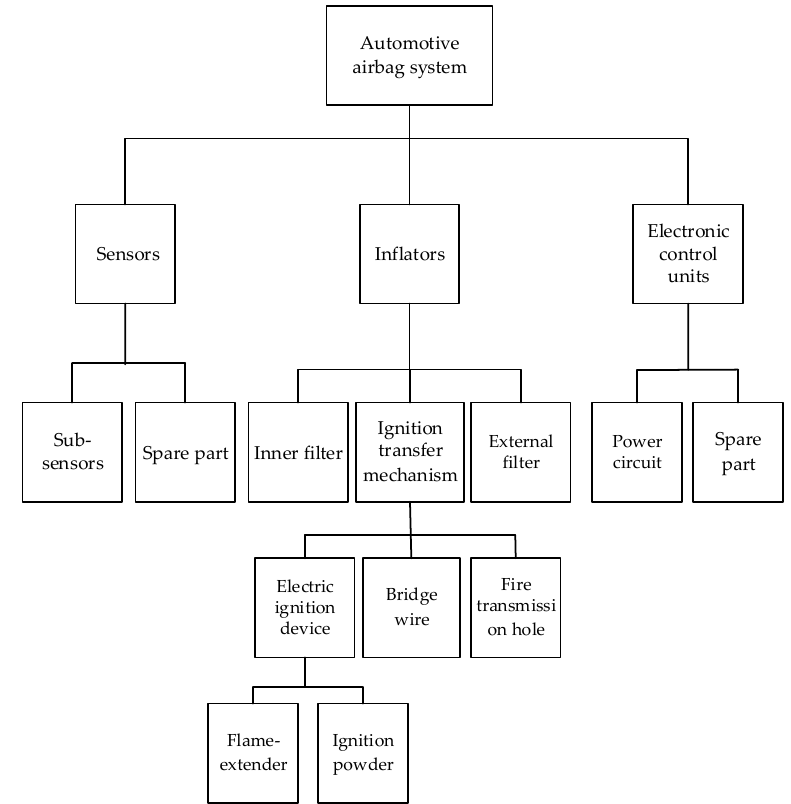
Figure 2. Dynamic fault tree of automotive airbag system.